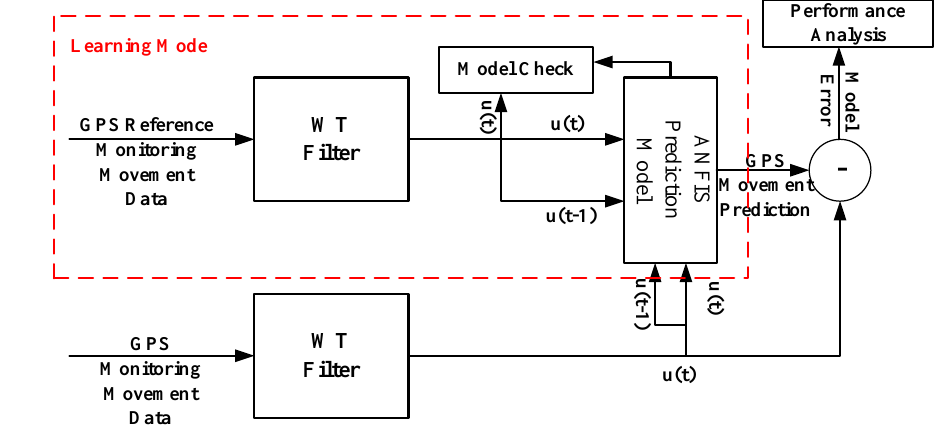
Figure 12. GPS prediction model performance analysis.